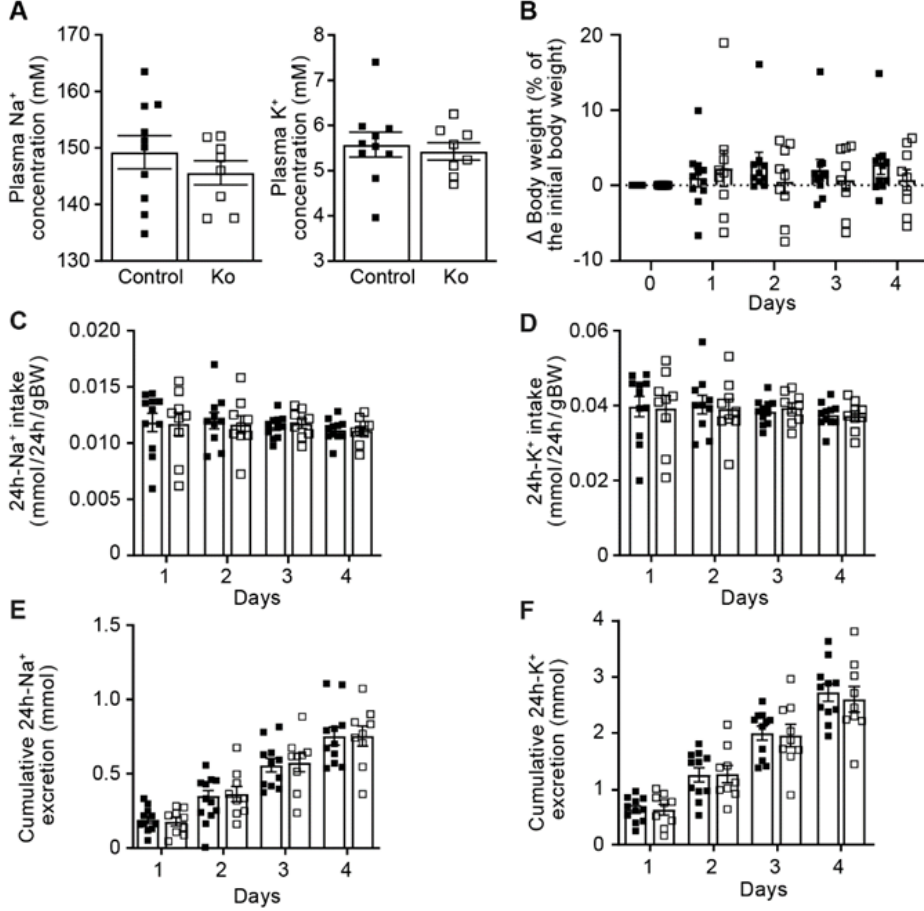
Figure 1. Prss8 PaxLC1 (knockout) mice displayed normal Na + and K + handling under standard Na + diet. ( A ) Plasma Na + and K + (mM) concentrations in control (left panel, black) and knockout (Ko, right panel, white square) mice. ( B ) Body weight changes (expressed as percent of initial body weight; control, n ≥ 10; Ko, n = 9), ( C ) 24h Na + and ( D ) K + intake and, ( E ) 24 h cumulative Na + and ( F ) K + (mmol/24 h/gBW) excretion; control, n = 11; Ko, n = 9). Results are presented as mean ± SEM (2 series of experiments, control: n = 10, knockout n = 8). ( A ) was analysed by an unpaired two-tailed t test, ( B – F ) by a multiple t -test. p values < 0.05 were considered statistically significant. Following a four-day high Na + diet, Prss8 knockout mice exhibited increased plasma Na + concentrations (Figure 2A) but did not show an impaired Na + and K + balance (Figure 2B–F) or altered metabolic parameters (data not